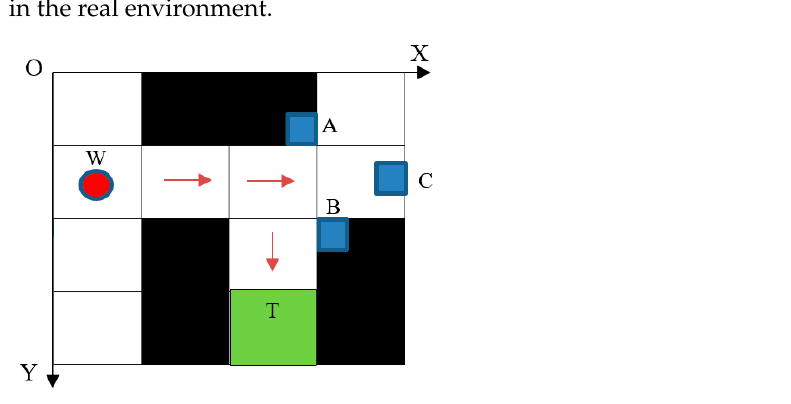
Figure 6. Coordinates of the wheelchair, landmarks, and target in simulated 2D grid map.